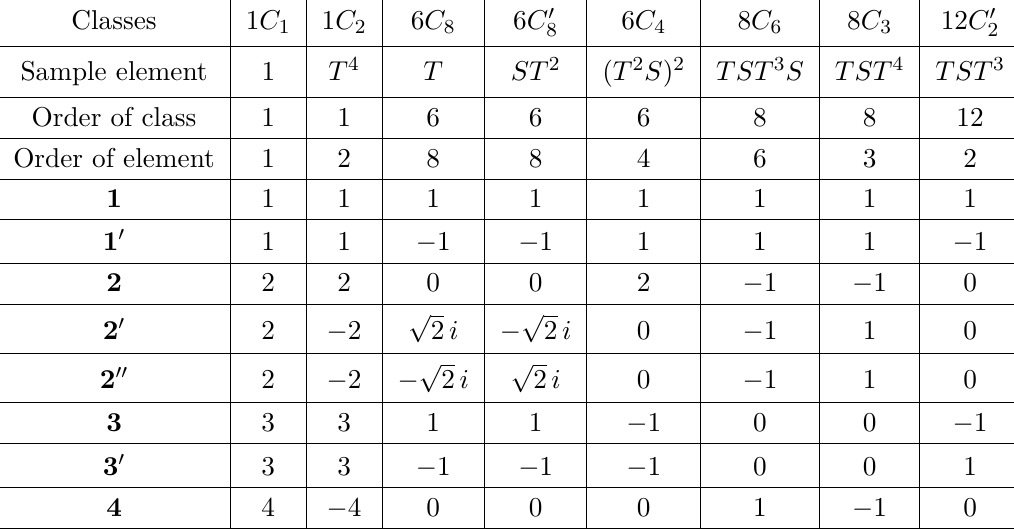
Table 4 . The character table of the group GL(2 , 3)